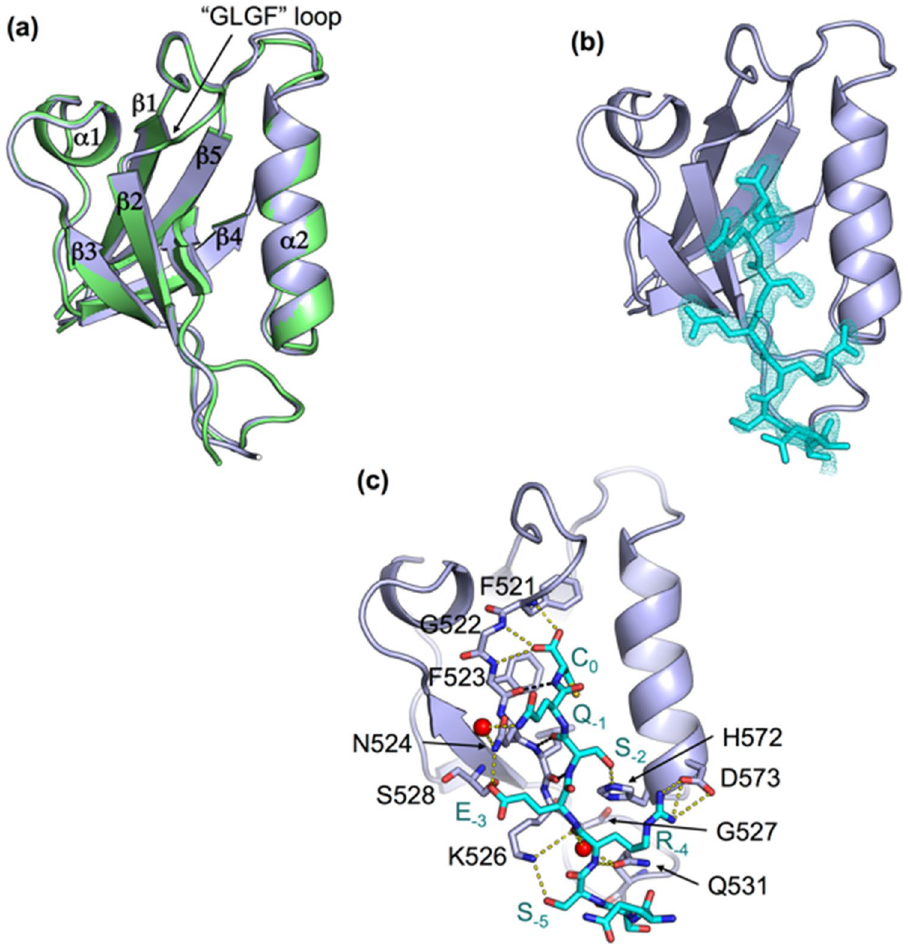
Figure 1. X-ray structure of PTPN3-PDZ bound to PBM-HBc. ( a ) Superimposition of the structures of PTPN3-PDZ bound to PBM-HBc (PDB ID: 6T36, light grey) and PBM-HPV16E6 (PDB ID: 6HKS, light green). ( b ) Representation of the density of the peptide in the binding groove of the PDZ domain. ( c ) Detailed views of the PTPN3-PDZ bound to PBM-HBc. Important residues are shown as sticks in CPK colors, molecules of water are represented as red spheres, and intermolecular H-bonds and polar contacts are shown as yellow dashed lines. Black dashed lines show the H-bond pairing with the